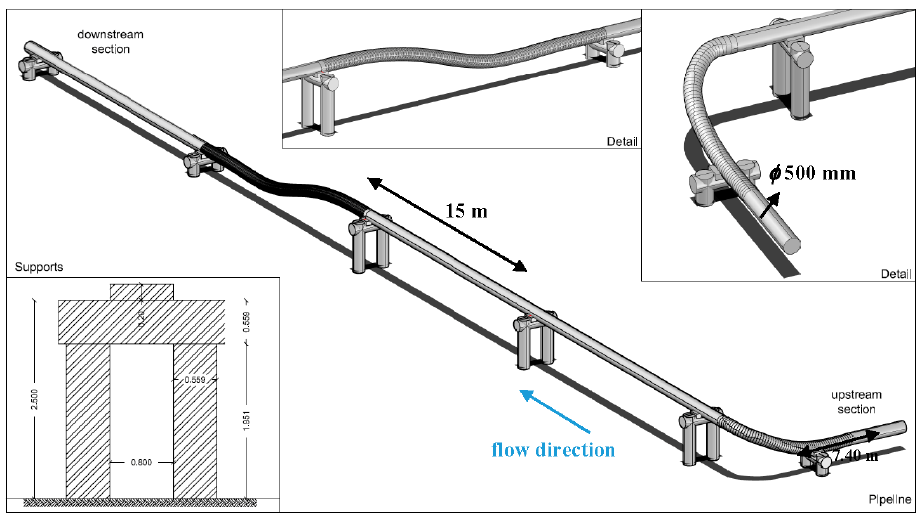
Figure 2. Pipeline system: part under analysis.